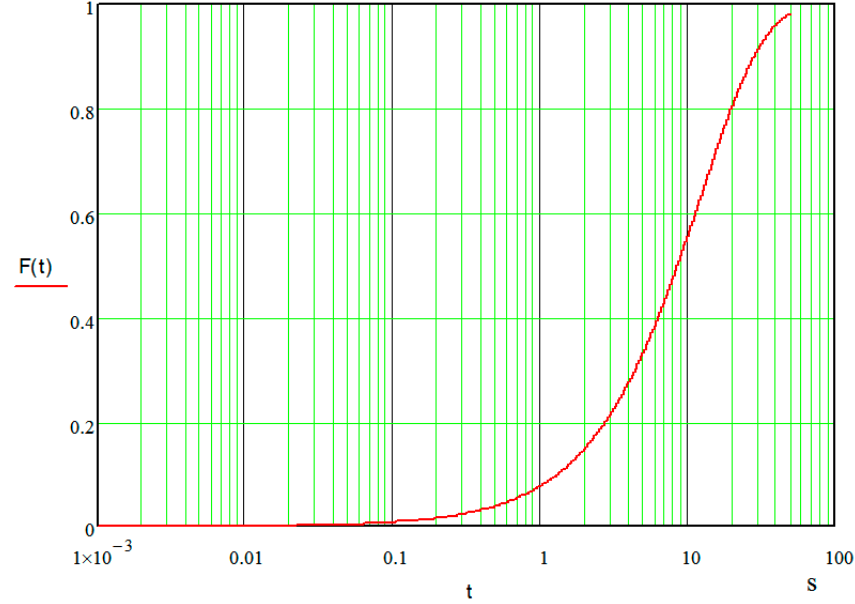
Figure 5. The graph of the distribution function of the data delivery time in the context of cyberattacks, when the initial data are specified in the calculation example.